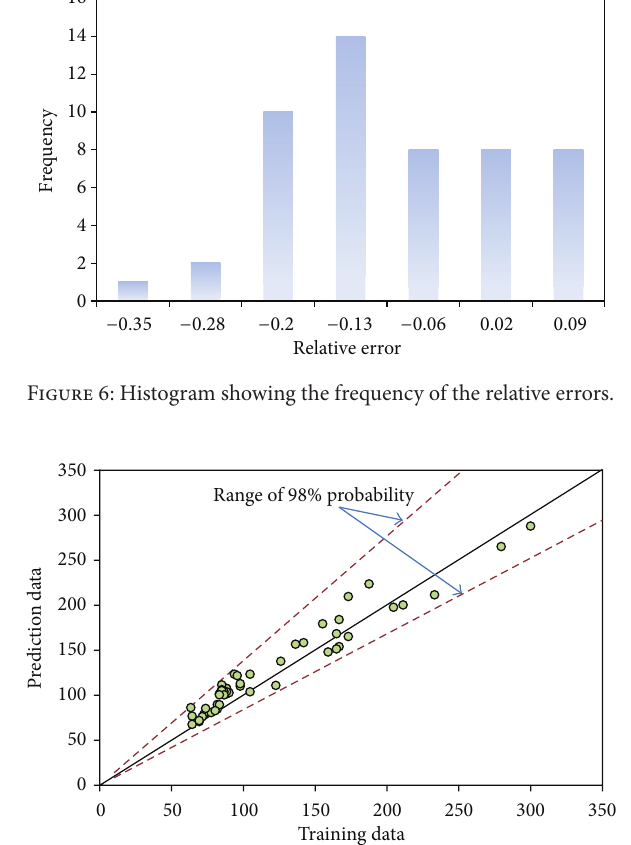
Figure 7: Range of 98% probability, based on the characteristic function